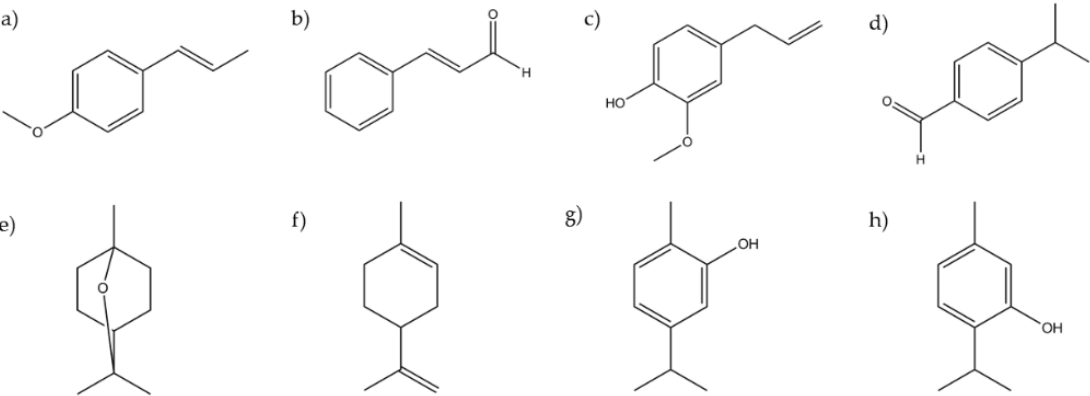
Figure 2. Chemical structures of the major components evaluated. ( a ) Anethole, ( b ) cinnamaldehyde, ( c ) eugenol, ( d ) cuminaldehyde, ( e ) eucalyptol, ( f ) limonene, ( g ) carvacrol, and ( h ) thymol.